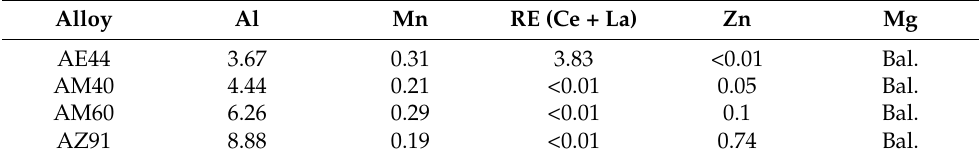
Table 1. Chemical compositions of the studied Mg alloys in wt.%.